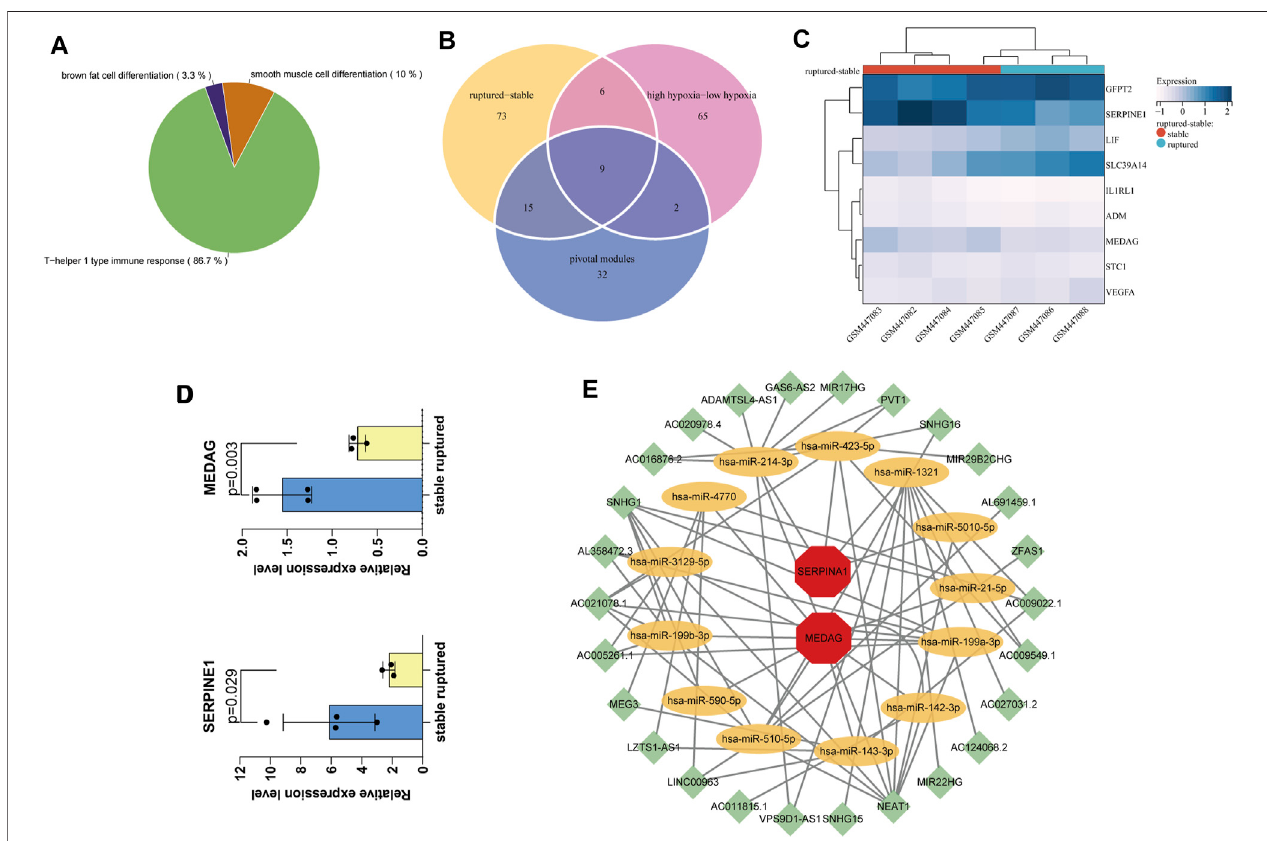
FIGURE 4 | Screening and validation of hub genes. (A) The most relevant gene modules with coenriched GO entries of high hypoxia and rAAA. (B) The Venn diagram shows nine candidate genes related to hypoxia and AAA rupture in the three cohorts. (C) Hierarchical clustering of the nine candidate genes in the mouse dataset GSE17901, fi nally identifying the fi nal hub genes MEDAG and SERPINE1. (D) Expression levels of MEDAG and SERPINE1 in GSE17901. (E) CeRNA network diagram. Green nodes indicate lncRNAs, yellow nodes indicate miRNAs, and red nodes indicate mRNAs.